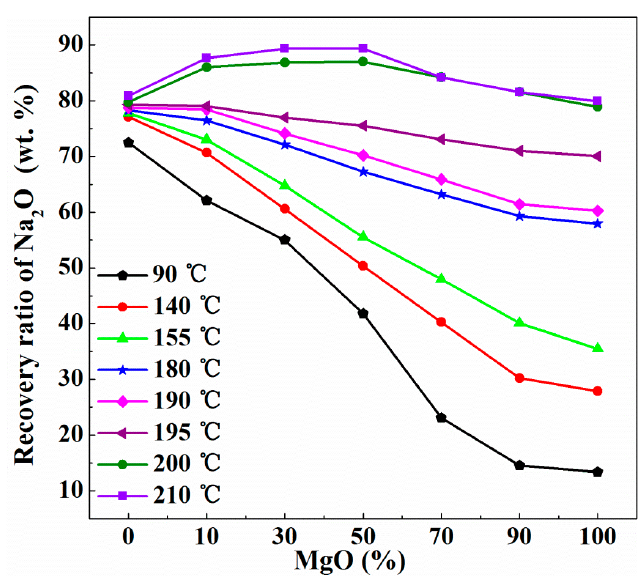
Figure 4. Influence of blending MgO and CaO on the recovery ratio of Na 2 O ( t = 3 h, % means the mole fraction of MgO addition).